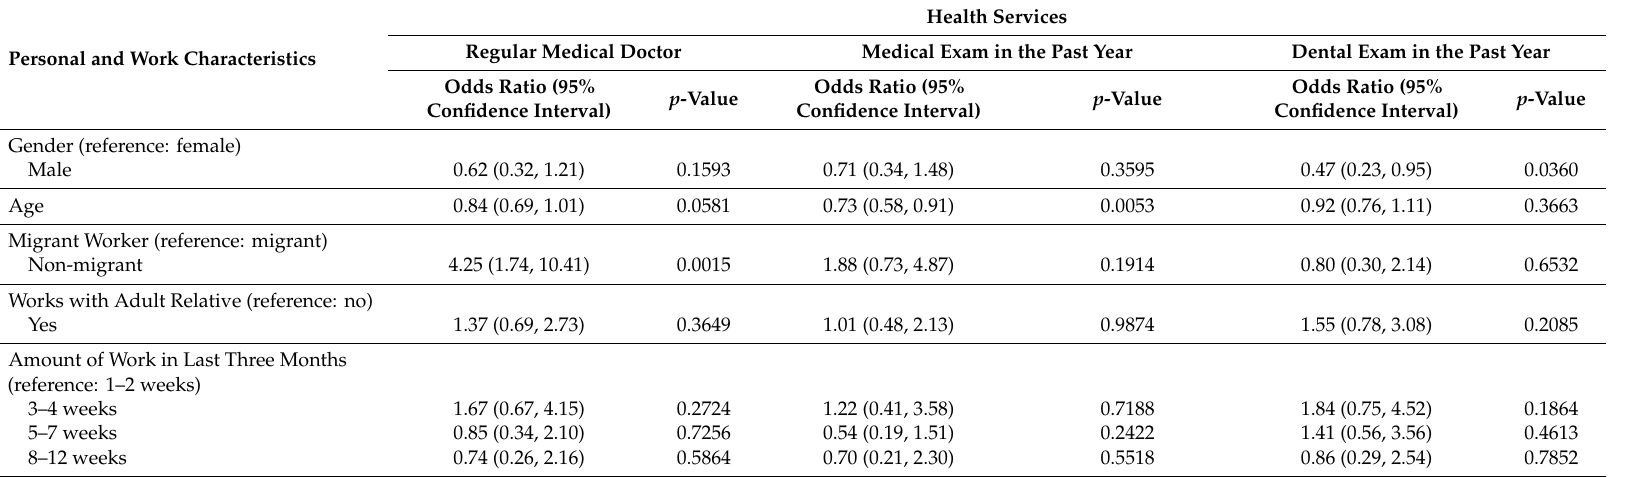
Table 4. Logistic regression analysis of personal and work characteristics with health characteristics for North Carolina Latinx child farmworkers,